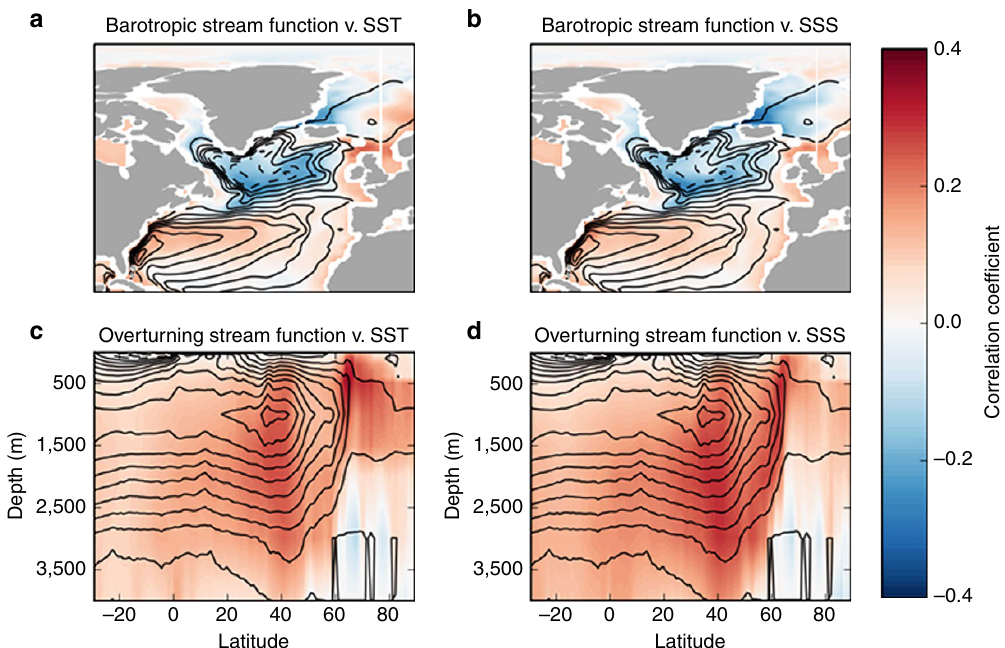
Figure 4 | Model analyses of the coherence between North Icelandic SSTand SSS variability and North Atlantic circulation. Correlation between annual North Icelandic SSTs against ( a ) barotropic stream function and ( c ) overturning stream function, and SSS against ( b ) barotropic stream function and ( d ) overturning stream function, in the North Atlantic derived from an ensemble CMIP5 preindustrial control simulation. The solid black lines show the time-mean stream